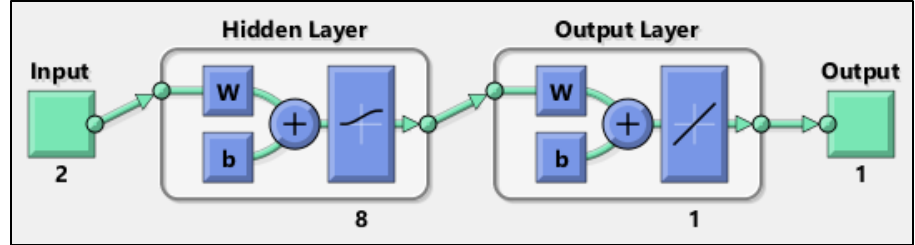
Figure 2. Diagram of the artificial neural network.